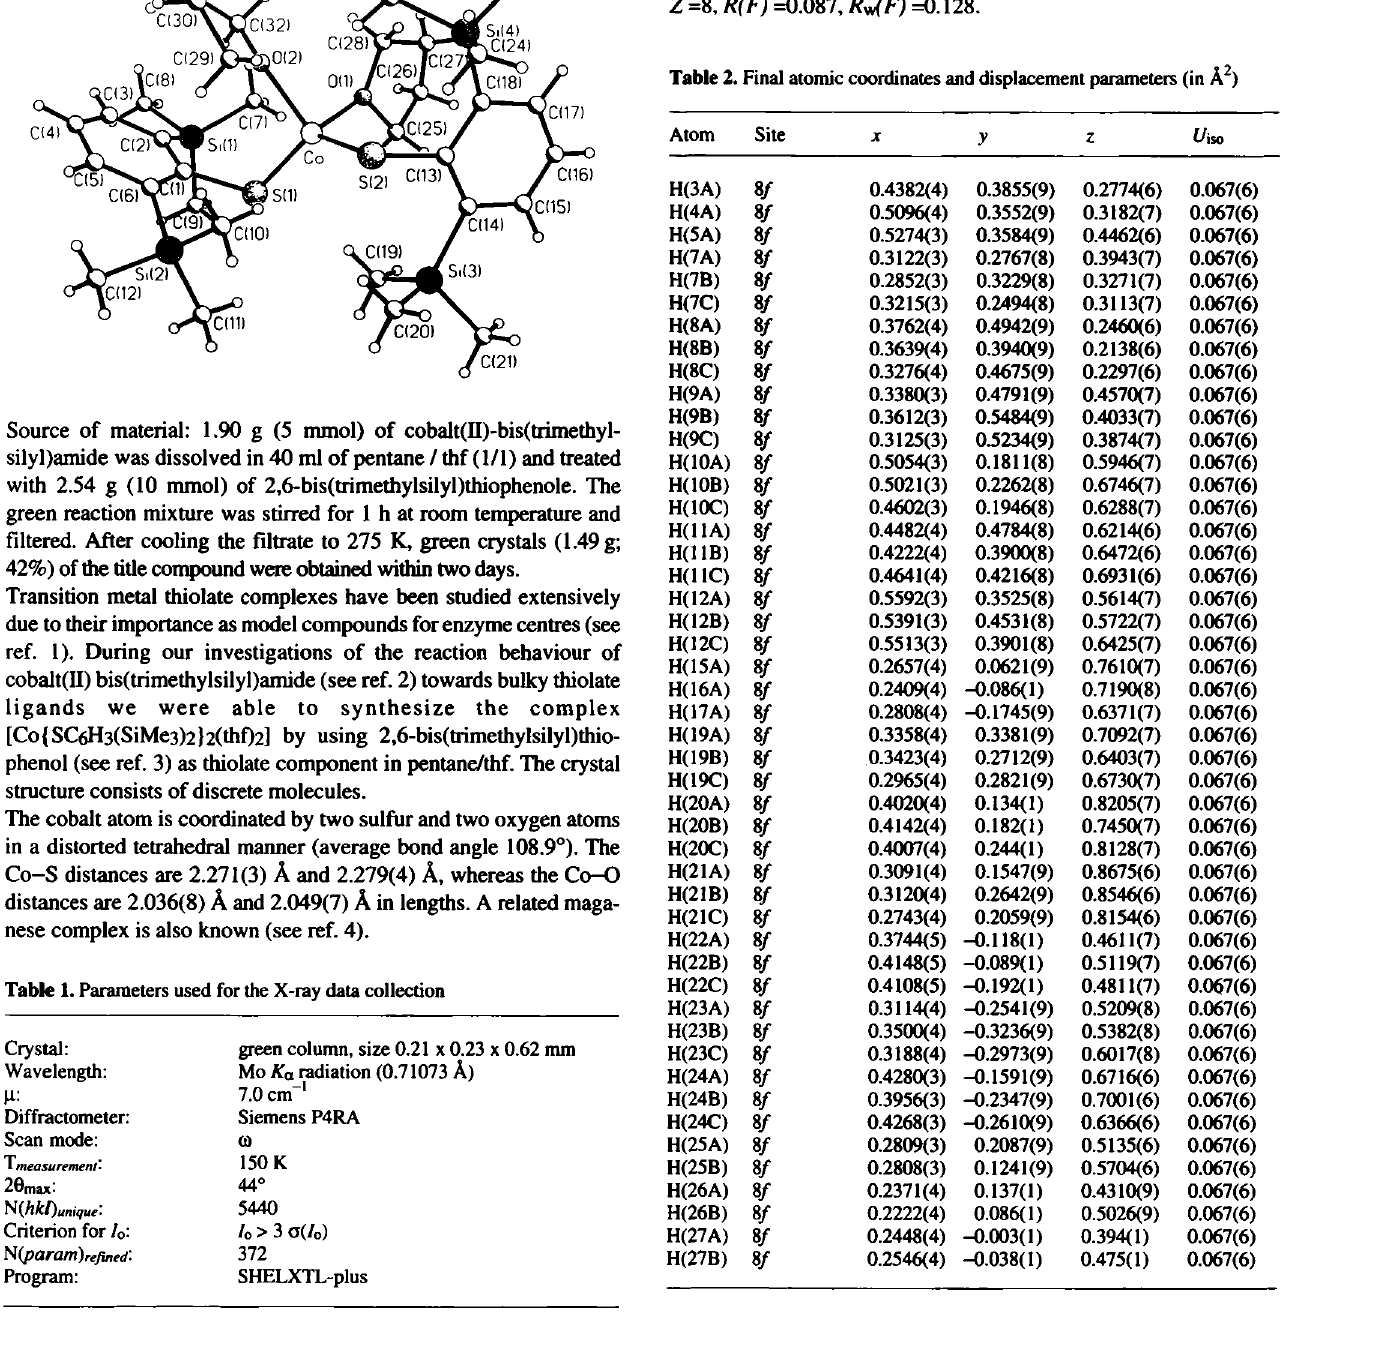
Table 2. Final atomic coordinates and displacement parameters (in